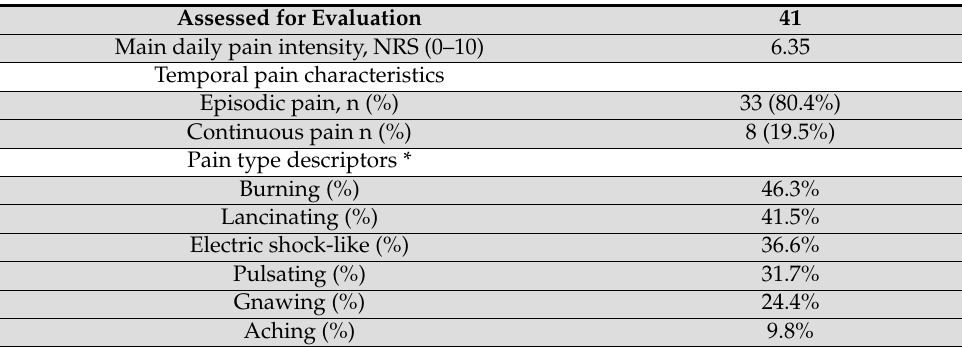
Table 2. Pain characterization of PIFP population (41 patients).